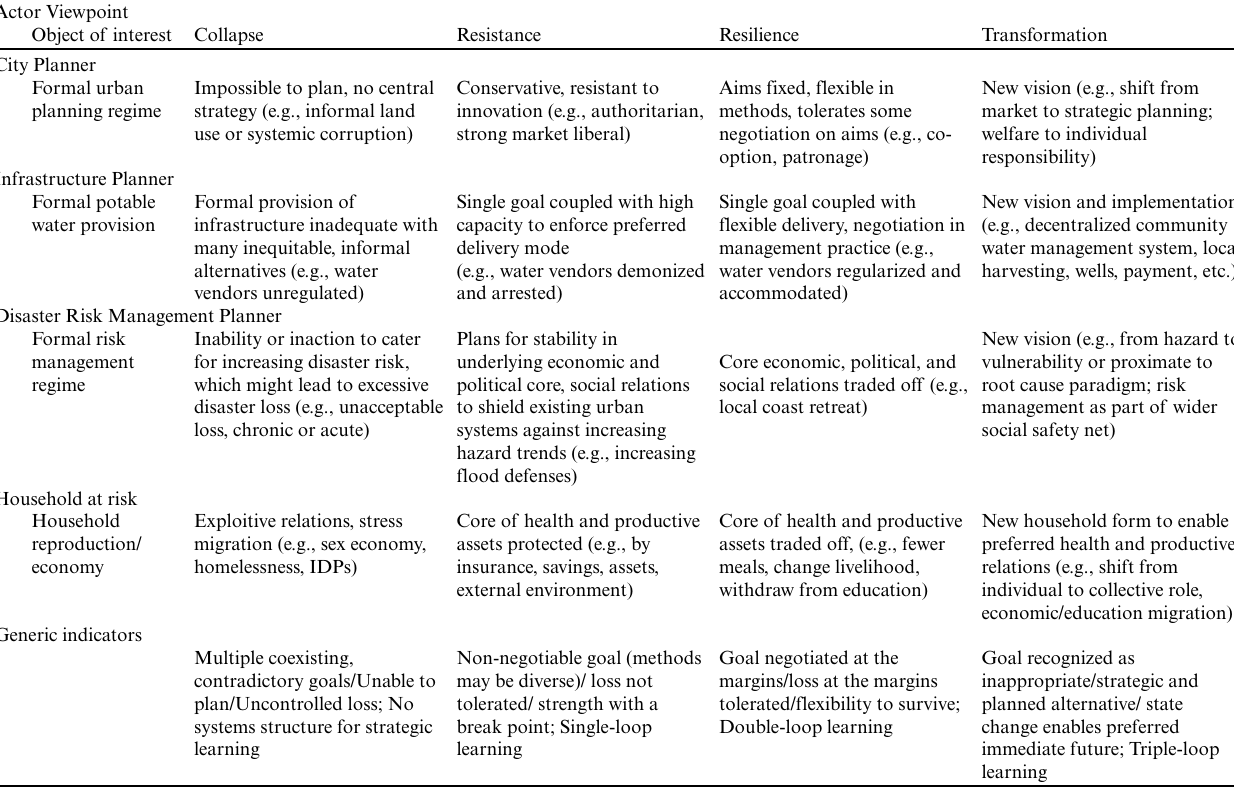
Table 2 . Risk management regimes each with actor viewpoint and object of interest. Actor Viewpoint Object of interest Collapse Resistance